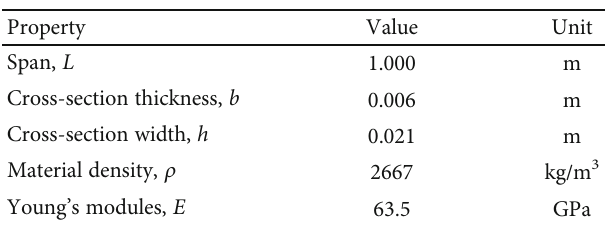
Figure 6: Block diagram of incremental dynamic inversion control based on deformation compensation. Table 1: Model